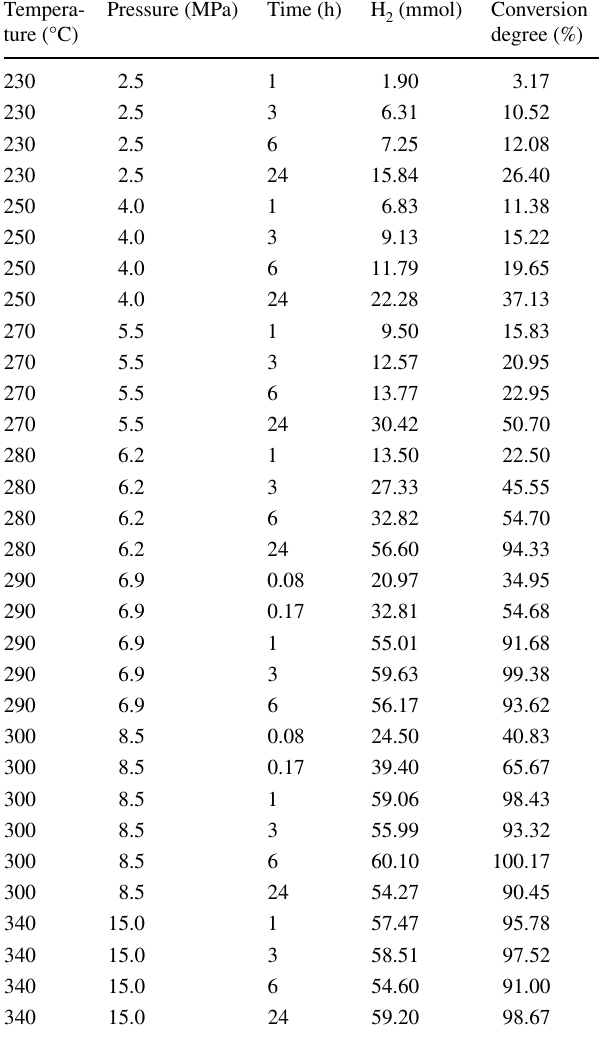
Table 1 Hydrogen production from reactions of water and aluminum